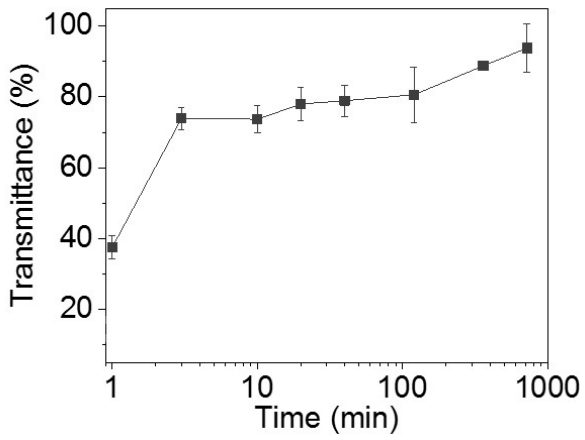
Figure 6. Microchannel transmittances of chips under optimized conditions as time goes on (1, 3, 10, 20, 40, 120, 360, and 720 min).